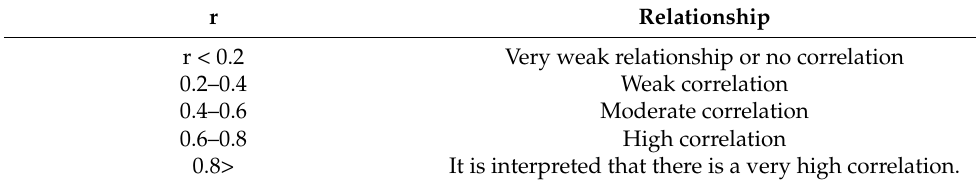
Table 2. Interpretation of the correlation coefficient [13].